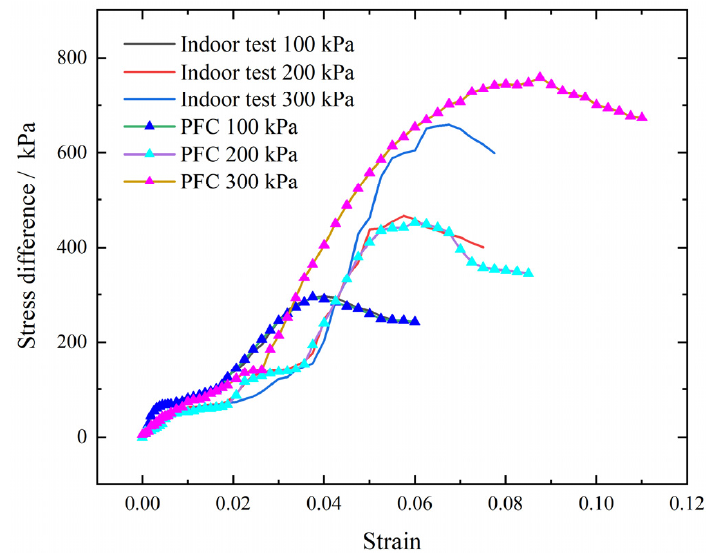
Figure 7. Stress–strain curves of the numerical triaxial tests of the gangue.